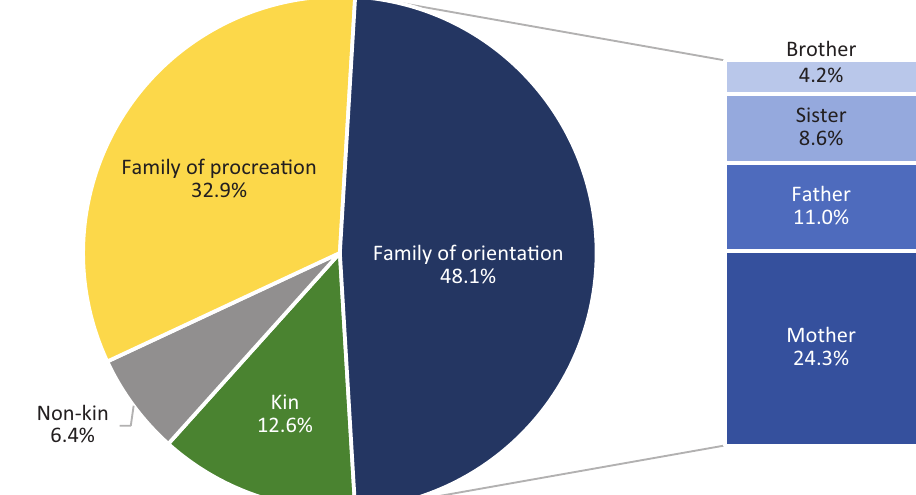
Figure 2. Significant persons that could provide support with care for dependent child(ren). Source: Data derived from the 2018 representative survey Migration and Family Processes: Representative Study ( N = 1005) and complemented with information by 977 respondents ( N / N = 28); there were about 918 significant persons who could provide such care (23.5% of all significant persons